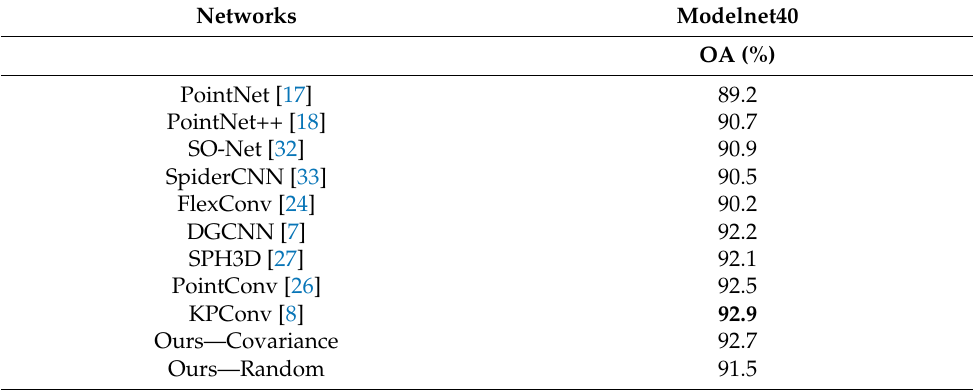
Table 1. Results for 3D shape classification: The metric is the overall accuracy (OA) for the Model- Net40 data. Ours—Covariance refers to the kernel points generated by the covariance matrix of the samples; Ours—Random randomly generated the kernel points.